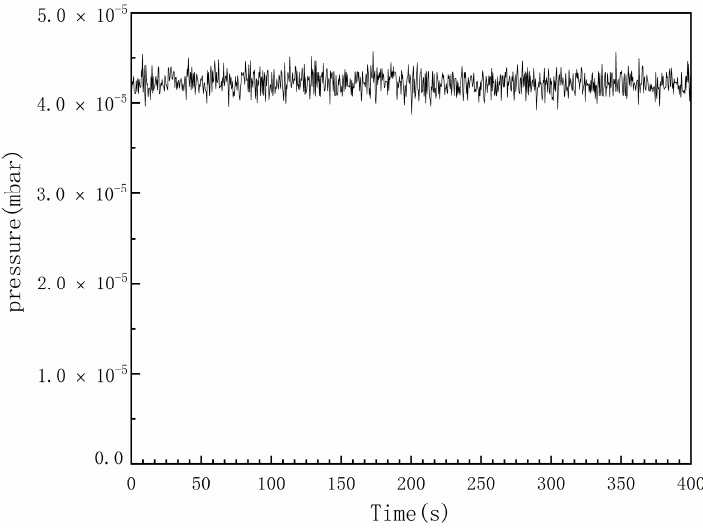
Figure 3. The change in the average pressure of the neutralized area of the vacuum chamber over time during the 400 s long-pulse.